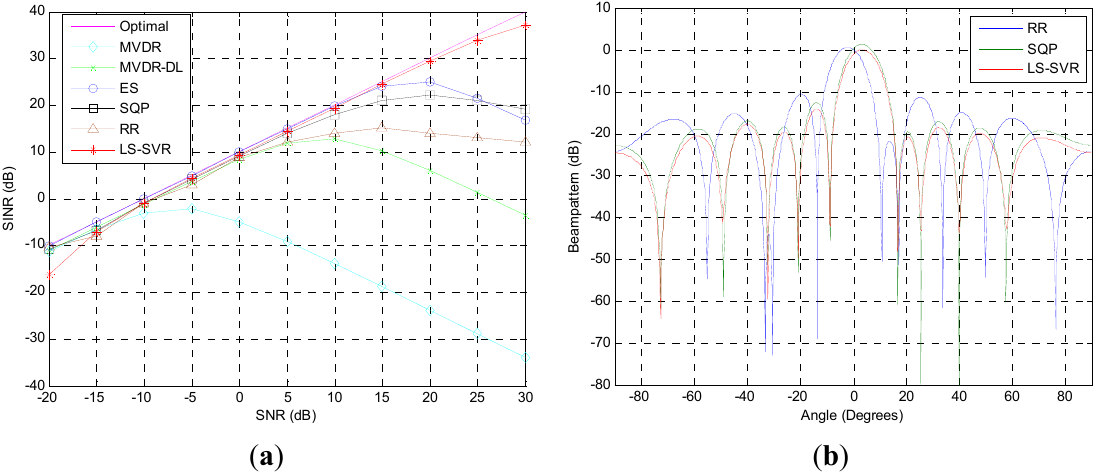
1. Scenario with only DOA mismatch ( a ) Output SINR versus SNR; ( b ) Beam-patterns, SNR = 10 dB, 2